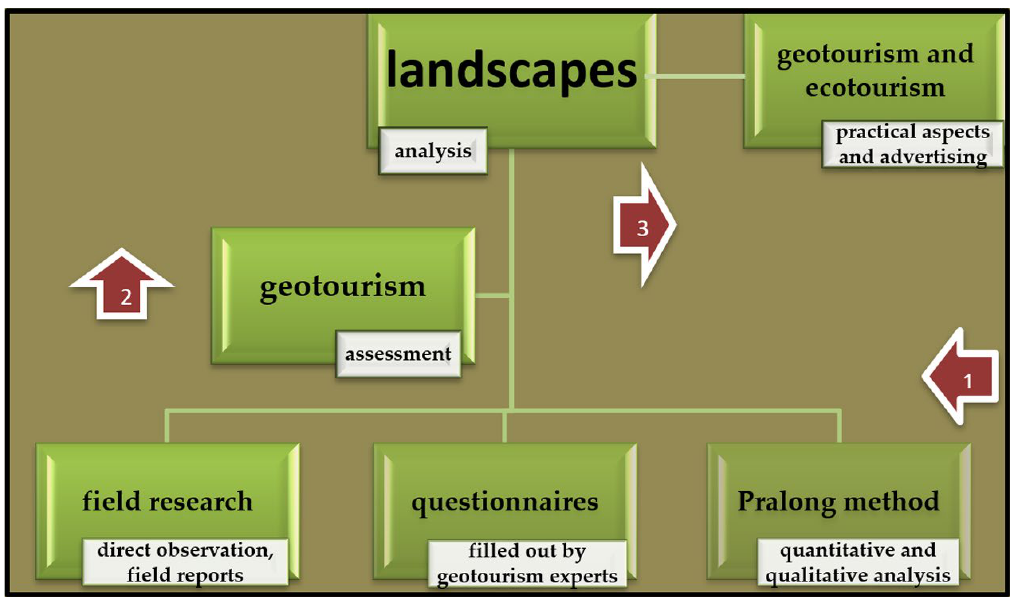
Figure 1. Research methodology scheme.